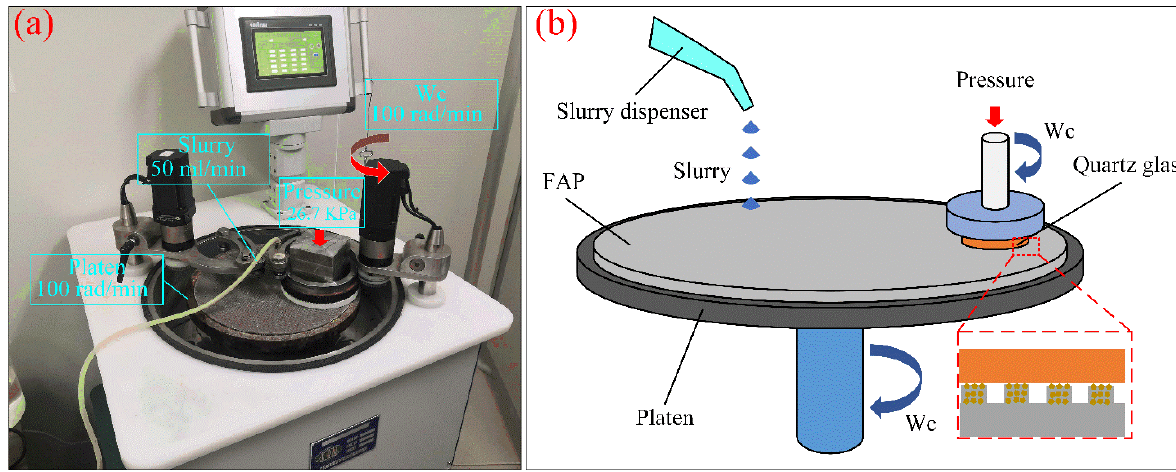
Figure 2. ZDHP-30B lapping and polishing machine and lapping schematic diagram: ( a ) test equip- ment; ( b ) working principle diagram.